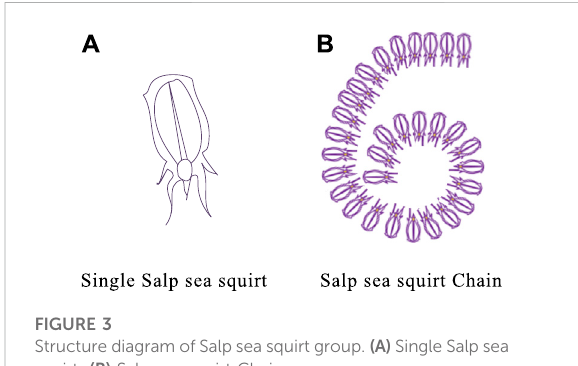
FIGURE 3 Structure diagram of Salp sea squirt group. (A) Single Salp sea squirt; (B) Salp sea squirt